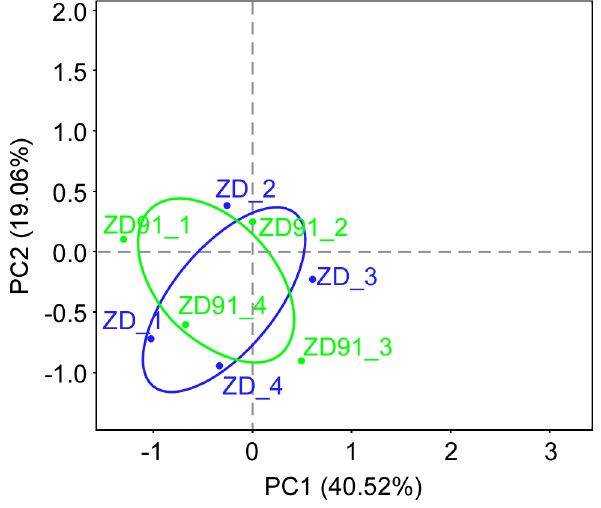
Figure 5. Principal coordinate analysis (PCoA) plot of samples using the weighted UniFrac distance metric. The variance explained by each principal coordinate axis is shown in parentheses. Datasets were subsampled to equal depth prior to the UniFrac distance computation. A circle was drawn with R around the samples of the same type (blue represents cultivar ZD, and green represents transgenic cultivar ZD91).